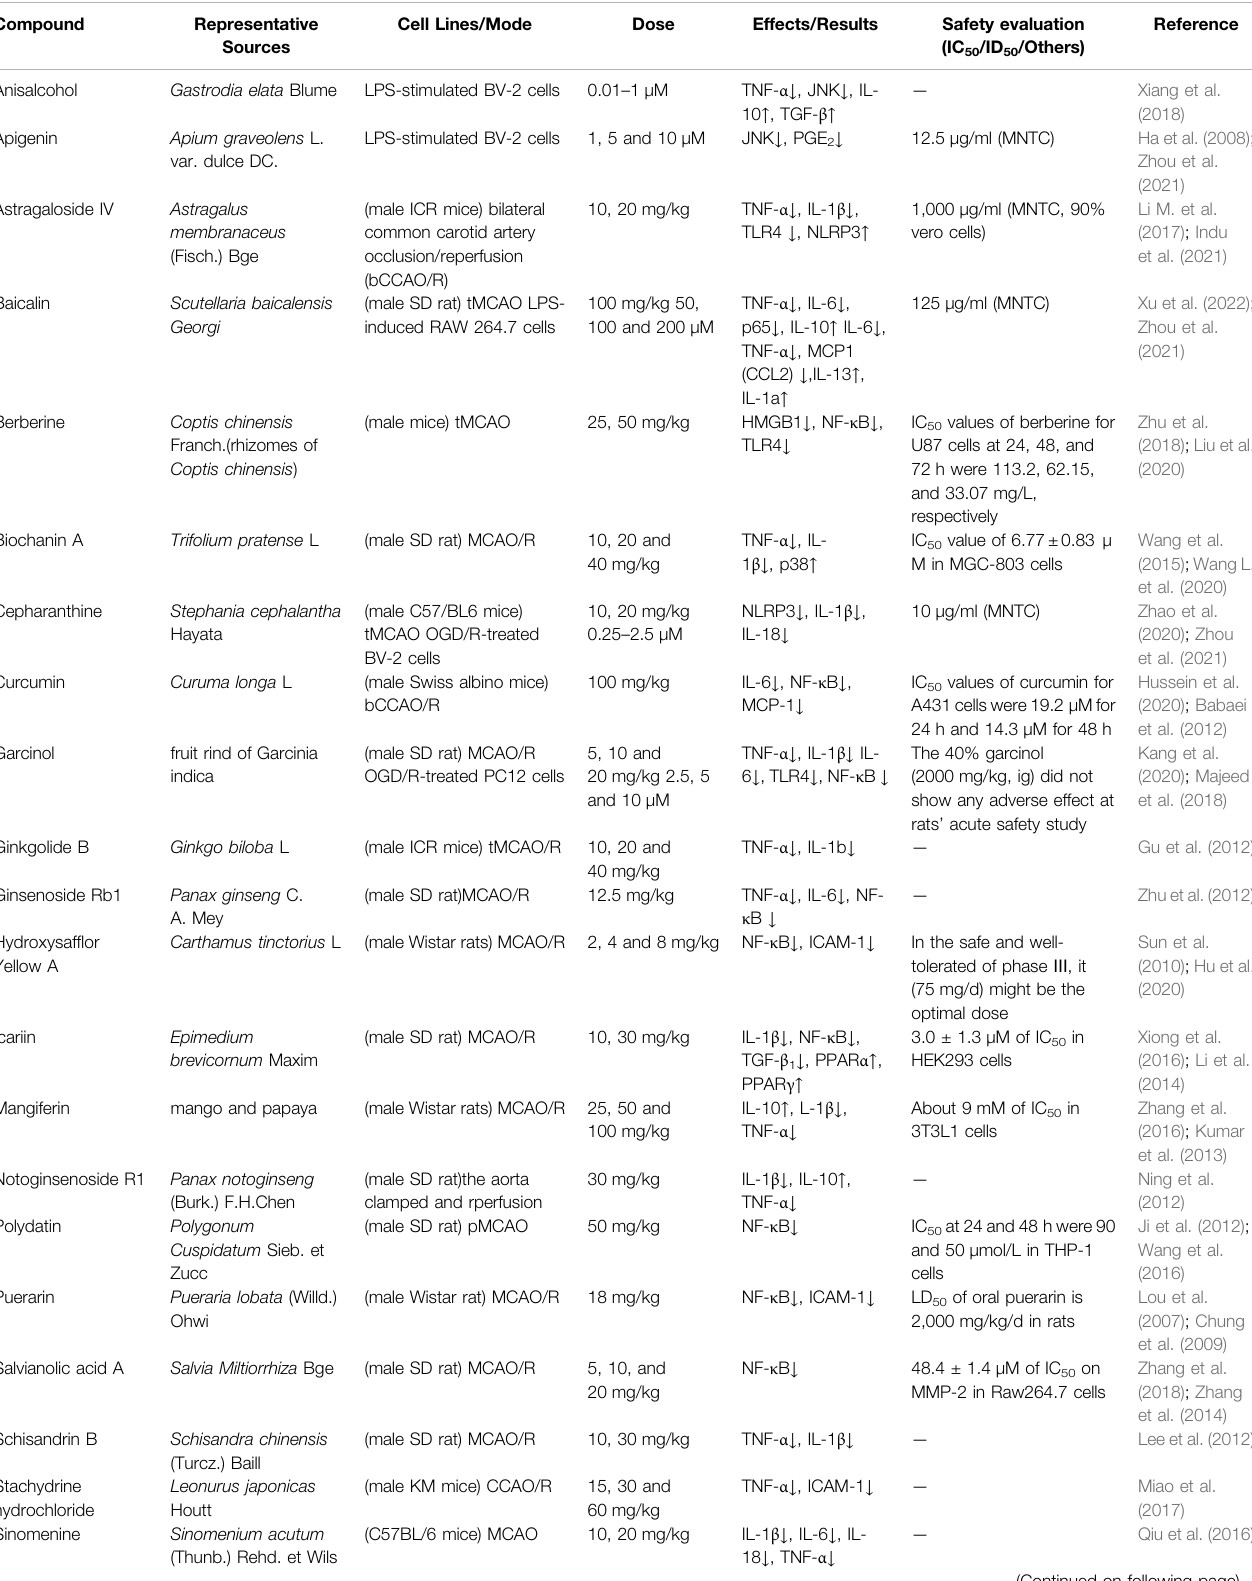
TABLE 1 | Twenty-six active compounds from natural medicine with anti-in fl ammatory effects in cerebral ischemia.